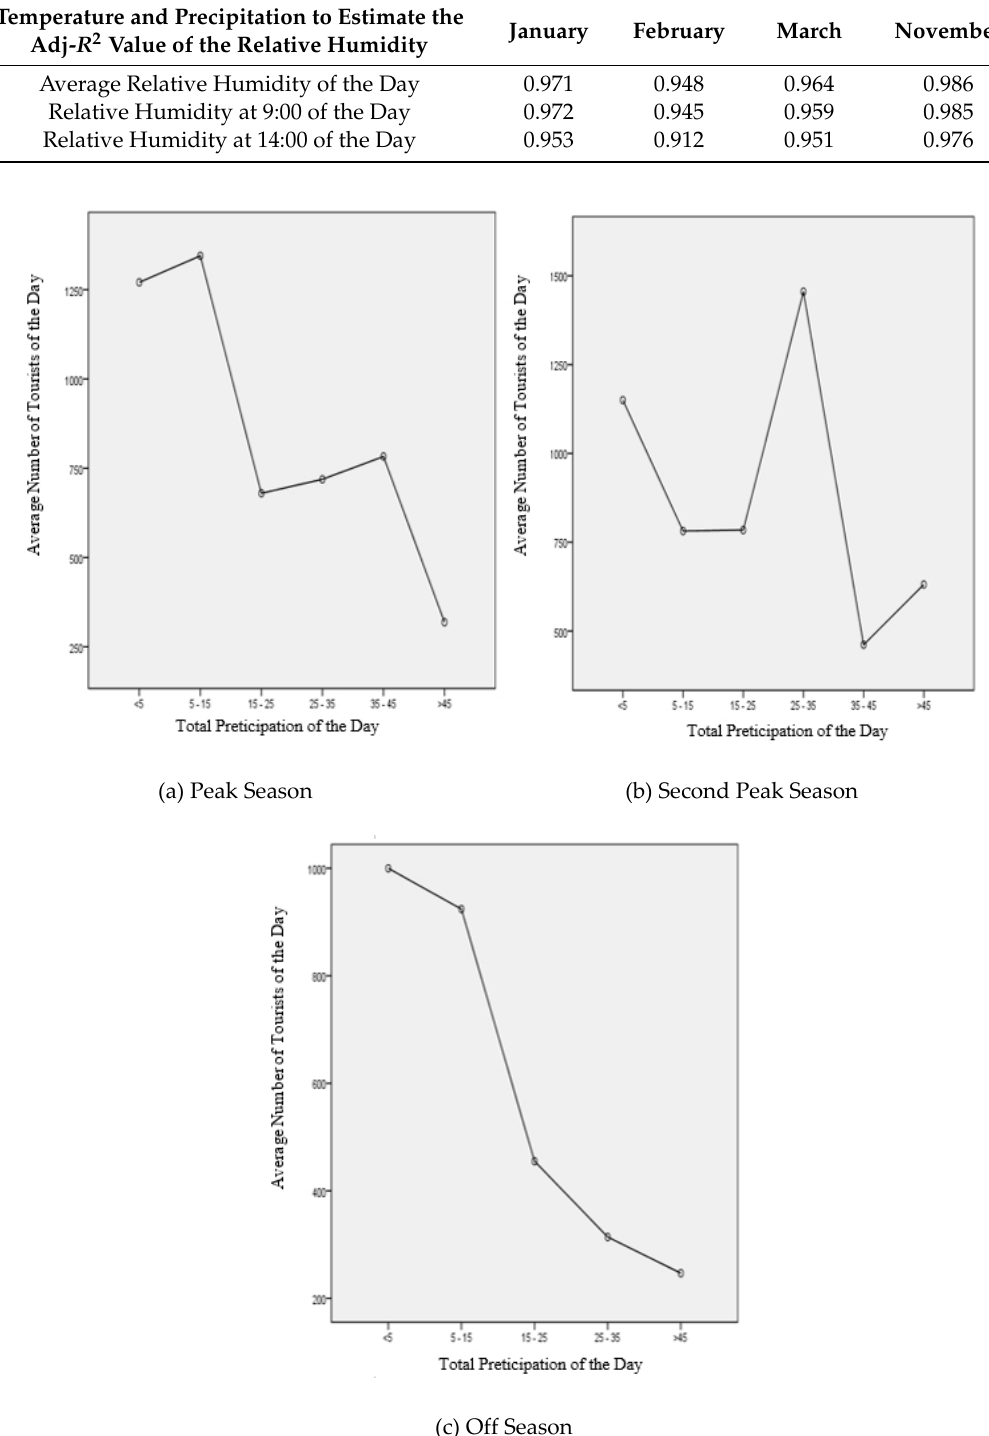
Figure 8. The relationship between the number of tourists in the peak season, second peak season, and off season on the grouped total precipitation of the